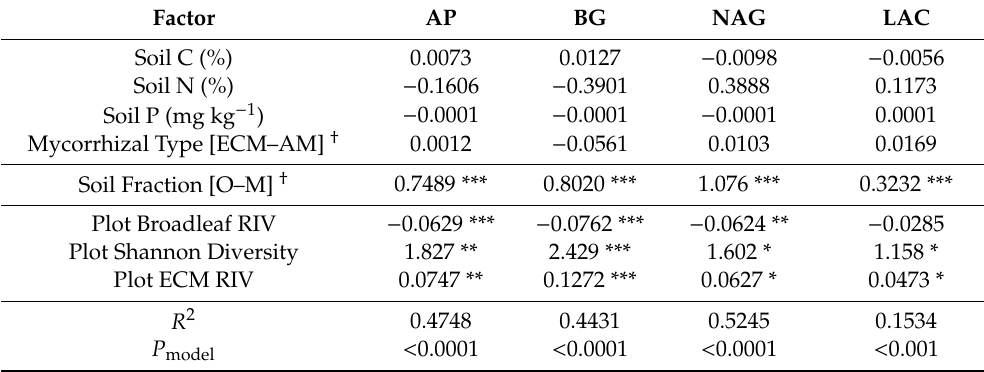
Table 2 . Parameter estimates for multiple linear regression of soil-level and plot-level predictors of ESE activities.